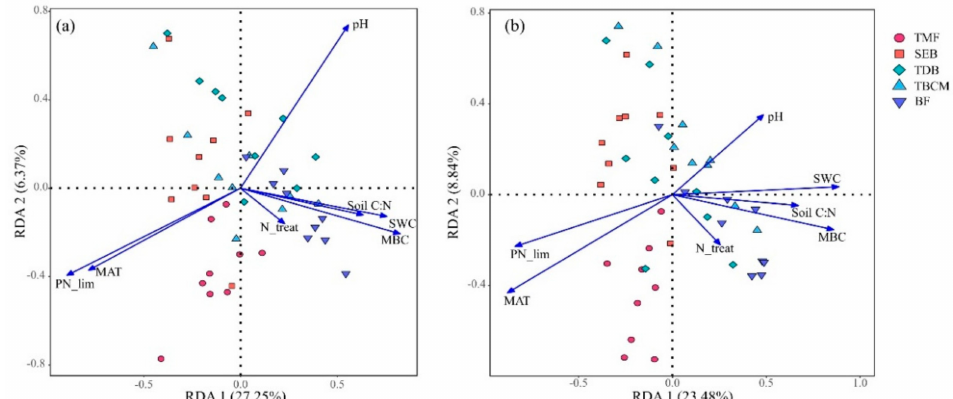
Figure 5. The results of redundancy analysis (RDA) showed the correlations between the fungal community and soil environmental heterogeneity across different forest types ( n = 9), for fungal phylum-level taxonomy ( a ) and functional compositions ( b ). TMF: tropical montane rain forest, SEB: subtropical evergreen broadleaved forest, TDB: temperate deciduous broadleaved forest, TBCM: temperate broadleaved and conifer mixed forest, BF: boreal